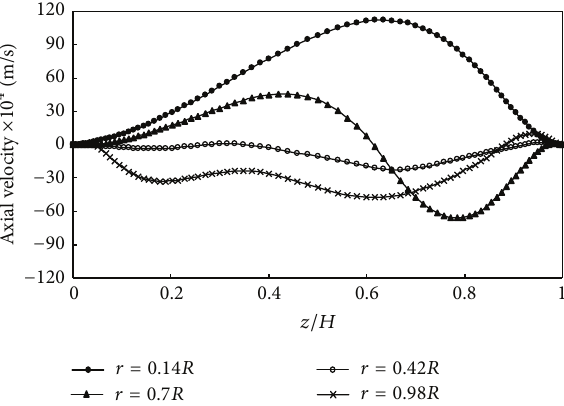
Figure 12: Profile of axial velocity along axial direction of tank.